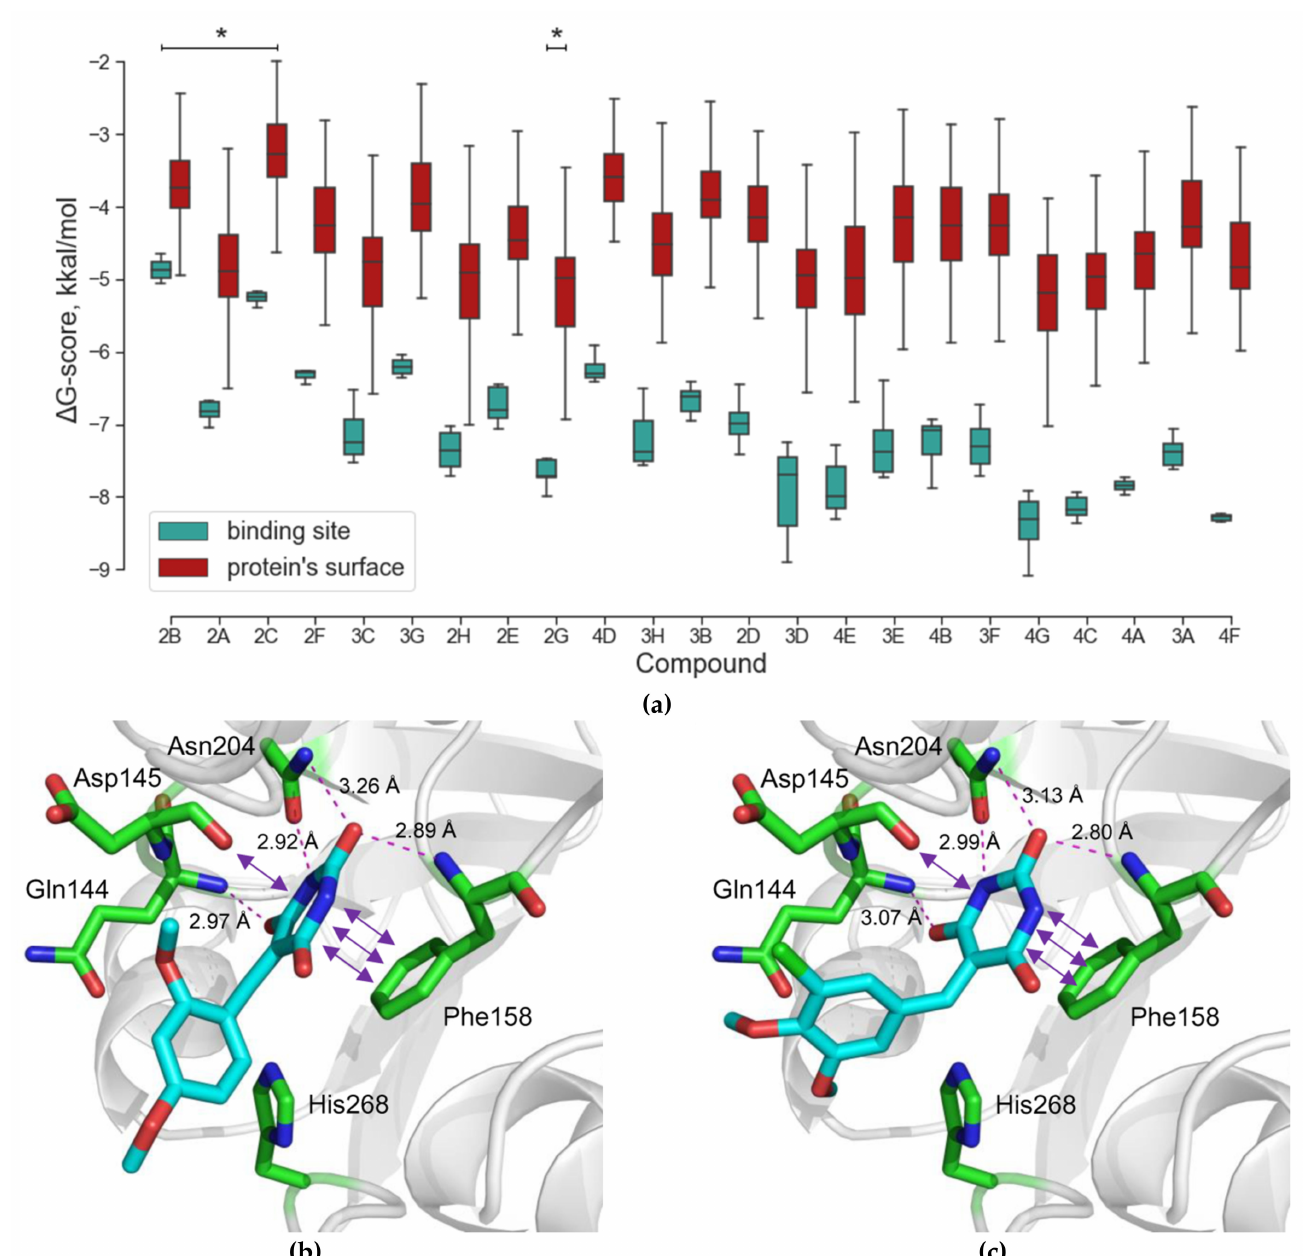
Figure 1. Docking of inhibitors into hUNG structure. ( a ) Illustration of the On-Top Docking procedure: the ∆ G-score calculated by Lead Finder for each of the selected compounds for a set of poses inside the binding site (cyan bars) and on the protein surface (red bars); * marks the potentially inactive compounds, for which p Median Test > 0.01 (see Table S1). ( b ) Structure of hUNG (PDB ID 3FCF [29]) with compound 4B docked into the active site. Lengths of the stabilizing hydrogen bonds are shown. Double-headed arrows indicate interactions with the π -system of the PyO3 moiety. ( c ) Same as (b) but with compound 4F docked into the hUNG active